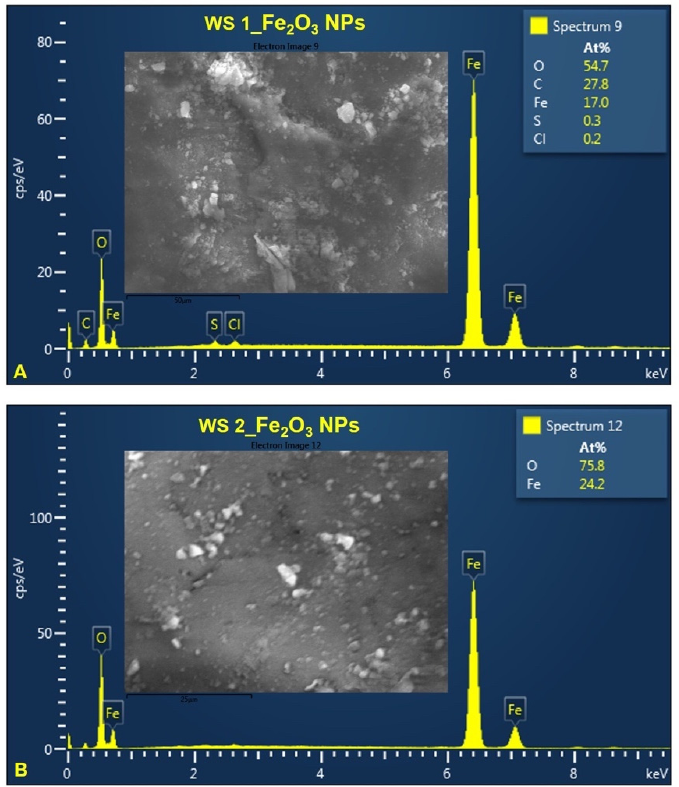
Figure 7. EDX spectra of IONPs obtained from WL: ( A ) Fe 2 O 3 NPs from WL at 80 ◦ C, ( B ) Fe 2 O 3 NPs from WL at 25 ◦ C.